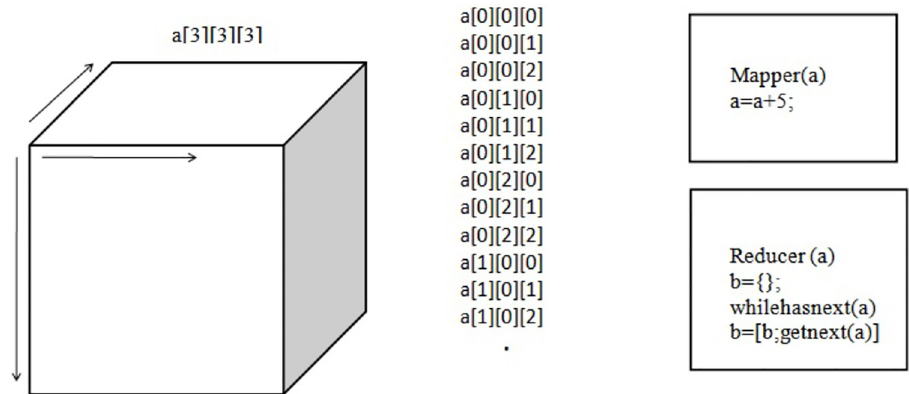
Fig 6. Mapper and reducer functions for each location.